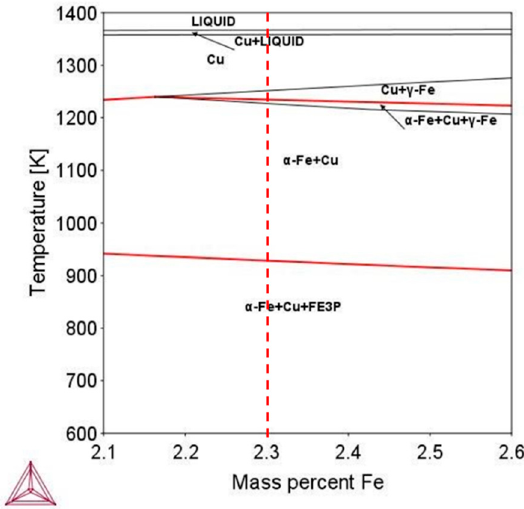
Figure 3. Isopleth section of CuFe 2 P alloy phase diagram—Fe dependency. The red lines show the temperatures at which α -Fe and Fe 3 P particles are formed depending on Fe content.